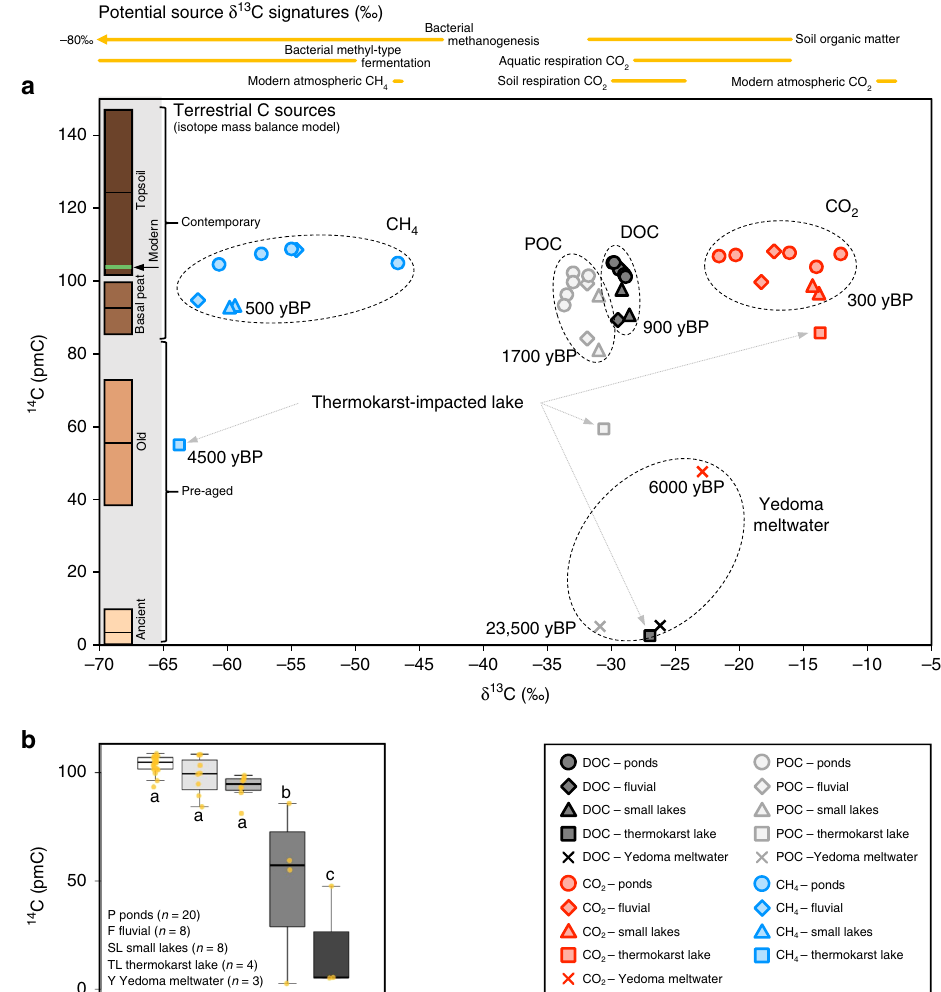
Fig. 2 Isotope ( 14 C and δ 13 C) composition of all carbon forms. a Dissolved organic carbon (DOC), particulate organic carbon (POC), and dissolved carbon dioxide (CO 2 ) and methane (CH 4 ) across all sample locations; the bars on the left indicate the 14 C (not δ 13 C) values (mean ± 1 σ ) of the fi ve sources used in the isotope mass balance; 14 C ages are indicative (years before present; yBP); δ 13 C signatures of potential carbon sources are indicated at the top: modern atmospheric CH 4 (ref. 45 ), bacterial methanogensis and bacterial methyl-type fermentation 24 , aquatic (permafrost freshwaters) respiration CO 2 (refs. 19,26 ), soil respiration CO 2 and soil organic matter from the study site (including Yedoma soils) 22 , and modern atmospheric CO 2 (ref. 25 ). b 14 C signatures across all carbon forms by sample location; the thick horizontal lines represent the median, limits of the boxes represent upper and lower quartiles, whiskers extend to 1.5 times the interquartile range, dots represent all data points, letters indicate statistical differences between the sample locations using ANOVA (see